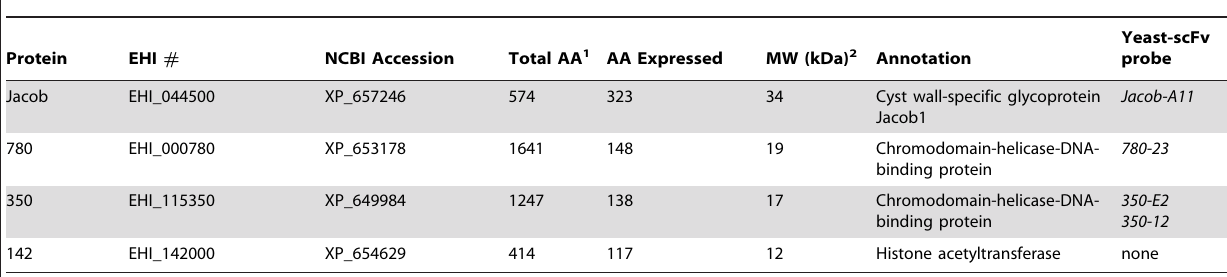
Table 1. E. histolytica proteins used in this study.